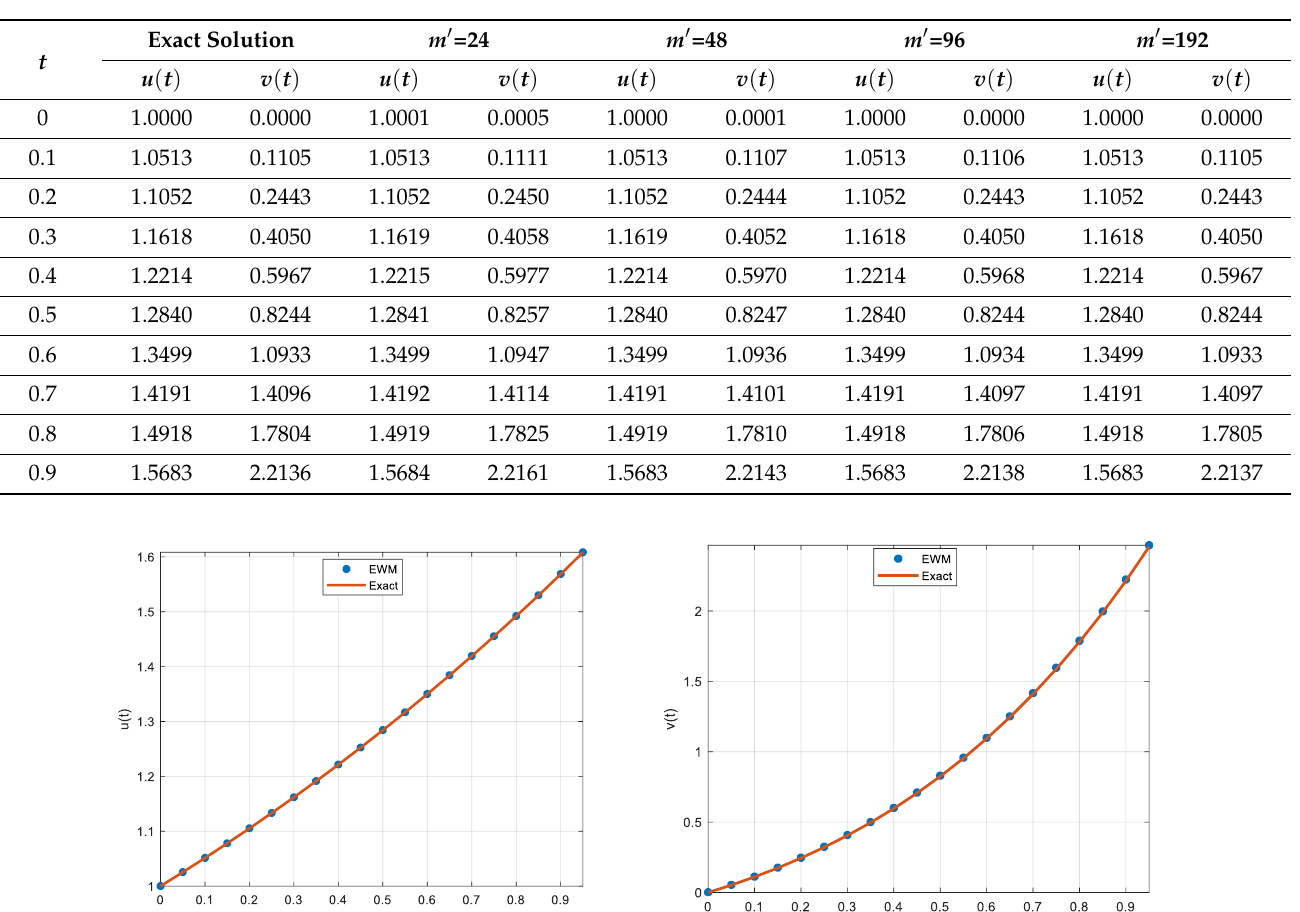
( ) v t () u t and for 1  = , 1 = for Example 3 (